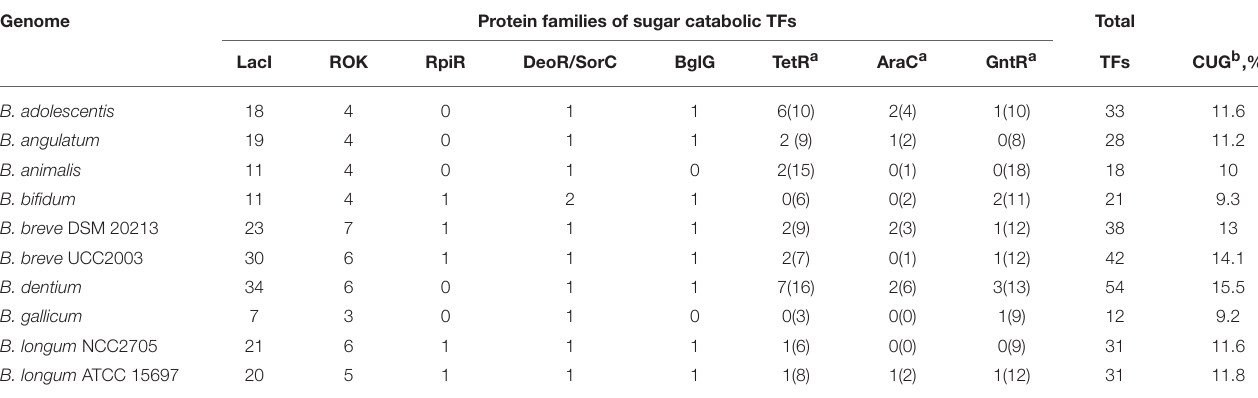
TABLE 1 | Distribution of TFs controlling carbohydrate metabolism in bifidobacteria. Genome Protein families of sugar catabolic TFs Total